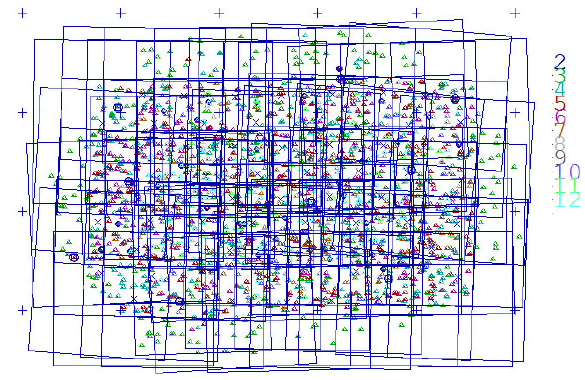
Fig. 3 : footprint overlap, DMCII 250 9.4cm GSD with object points color coded depending upon number of images / point The image tie of the test blocks is optimal, so the DMCII 250 block with 9.4cm GSD (Fig. 3) contains points located in up to 12 images. Only the operational block taken with the DMCII 230 has depending the stepwise progress few strips which are only poorly